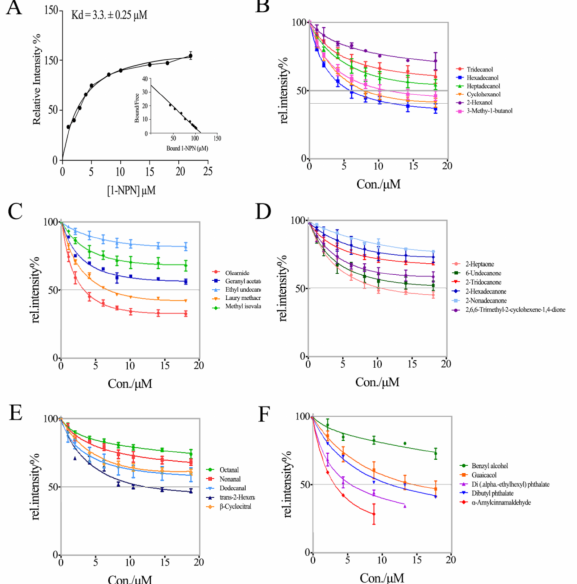
Figure 3. Binding affinity of the recombinant Lmig CSPIII to semiochemicals. ( A ) The dissociation curve of Lmig CSPIII with the fluorescent reporter, 1-NPN. Relationship between bound 1-NPN ( X -axis) and bound/free 1-NPN ( Y -axis) in the system is aligned in a Scatchard plot. ( B – F ) Binding affinity of Lmig CSPIII to alcohol ( B ), esters ( C ), ketones ( D ), aldehyde ( E ), and aromatic compounds ( F ). Relative intensity indicates fluorescent values at 410 nm. Of all tested chemicals, only those with effectively reduced fluorescent intensity within 20 µ m are shown. Each point represents the mean ± S.E.M of three independent